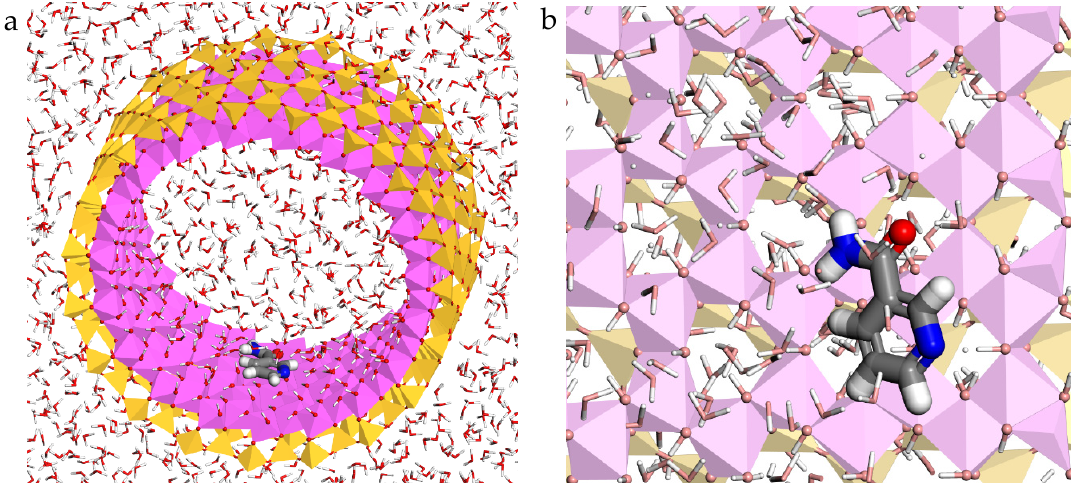
Figure 3. Optimized adsorption complex of the niacinamide adsorbed on the halloysite internal surface with water molecules, views from (001) ( a ) and (100) ( b ) planes. The Si, Al, H, C, O, and N atoms are represented in yellow, pink, white, grey, red, and blue colours, respectively.